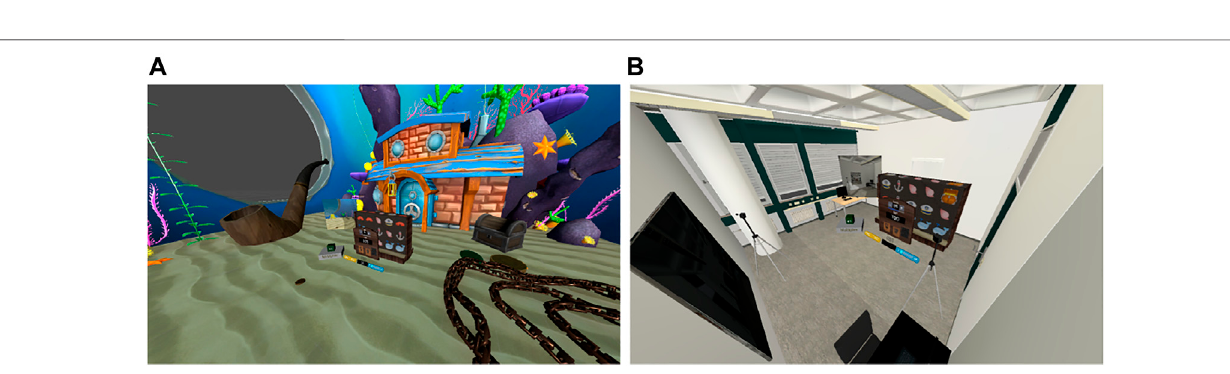
Frontiers in Virtual Reality |